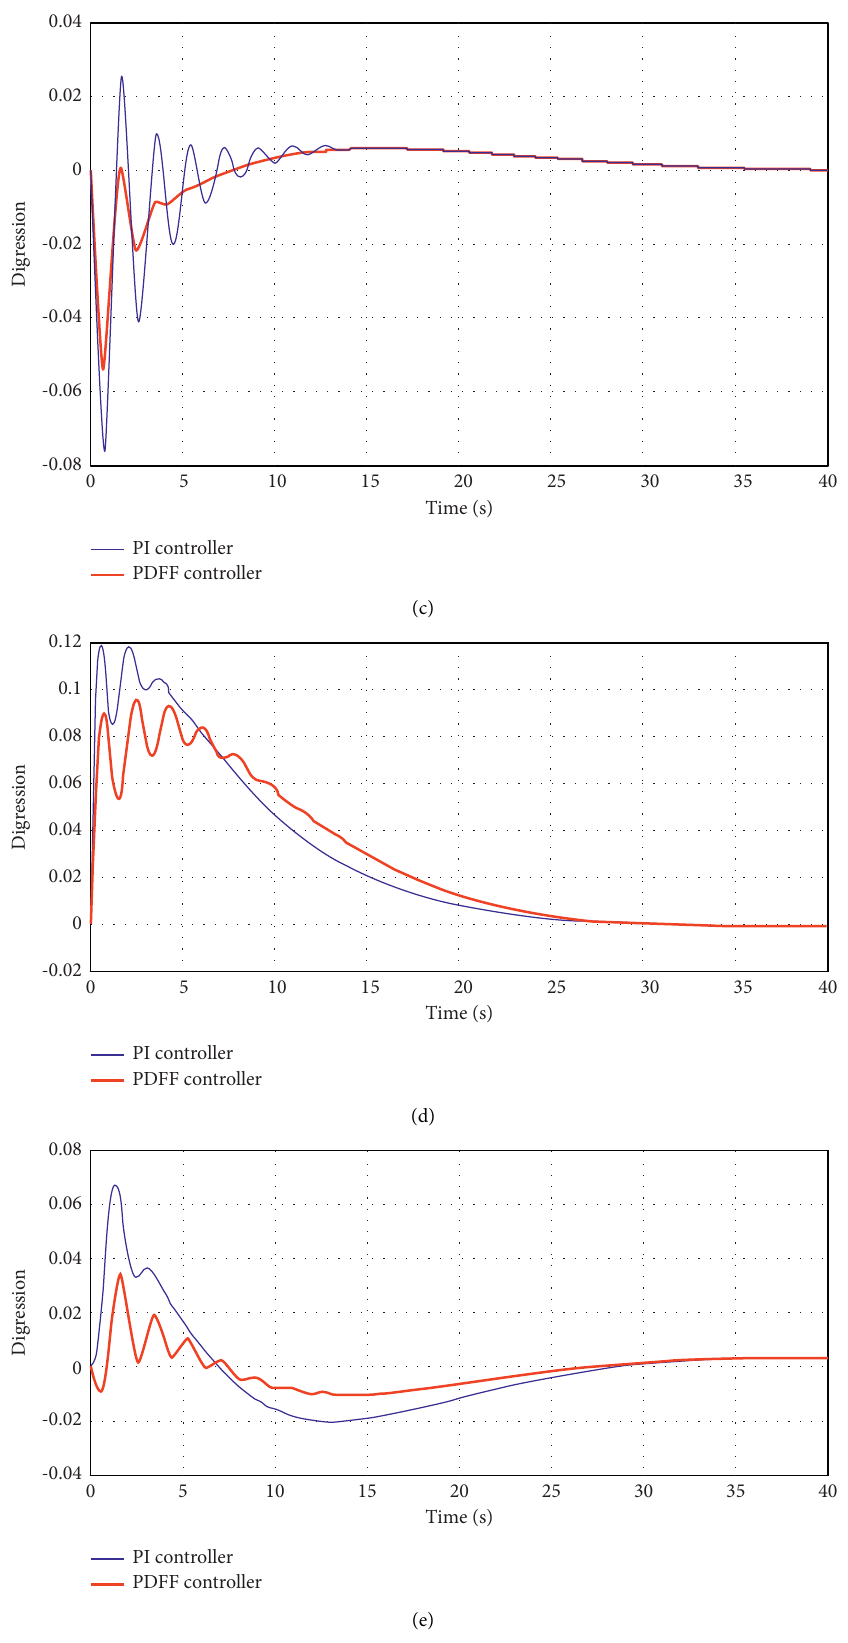
Figure 5: Flowchart for optimizing the parameters of PI controller using